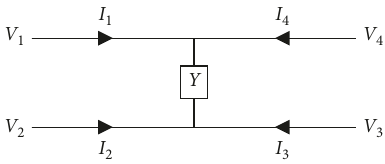
Figure 5: Schematic of shunt capacitance as four port block.